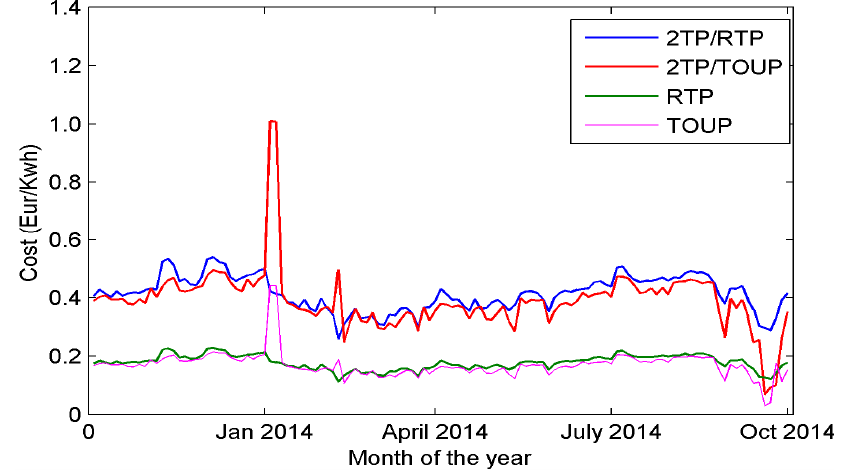
Figure 7. RTP and RTP/2TP vs. TOUP and 2TP/TOUP cost scheduling solution for exact algorithm.